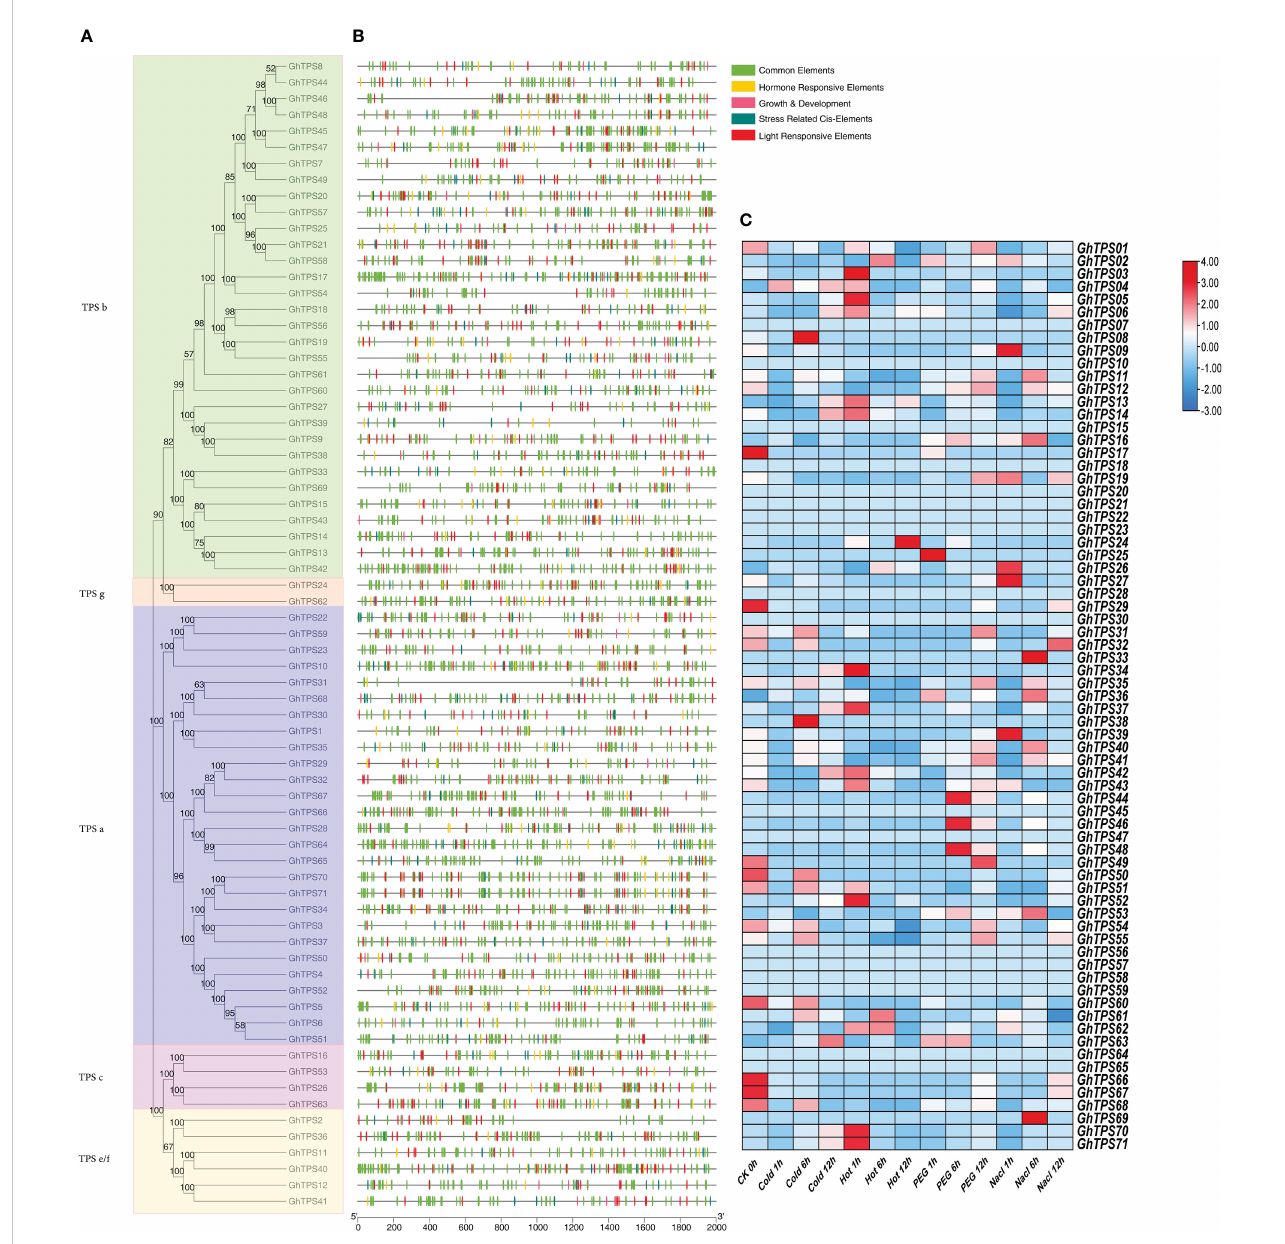
FIGURE 8 Expressed genes analysis and cis-acting elements of the GhTPS gene family. (A) Phylogenetic tree of GhTPSs. (B) Cis-elements of GhTPSs. (C) Expressed analysis of GhTPSs at different time points (0, 1, 6, 12h) under cold, hot, salt, PEG